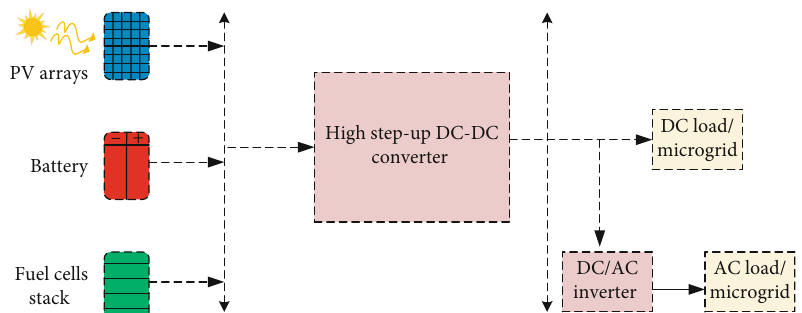
Figure 1: Renewable energy system [4].